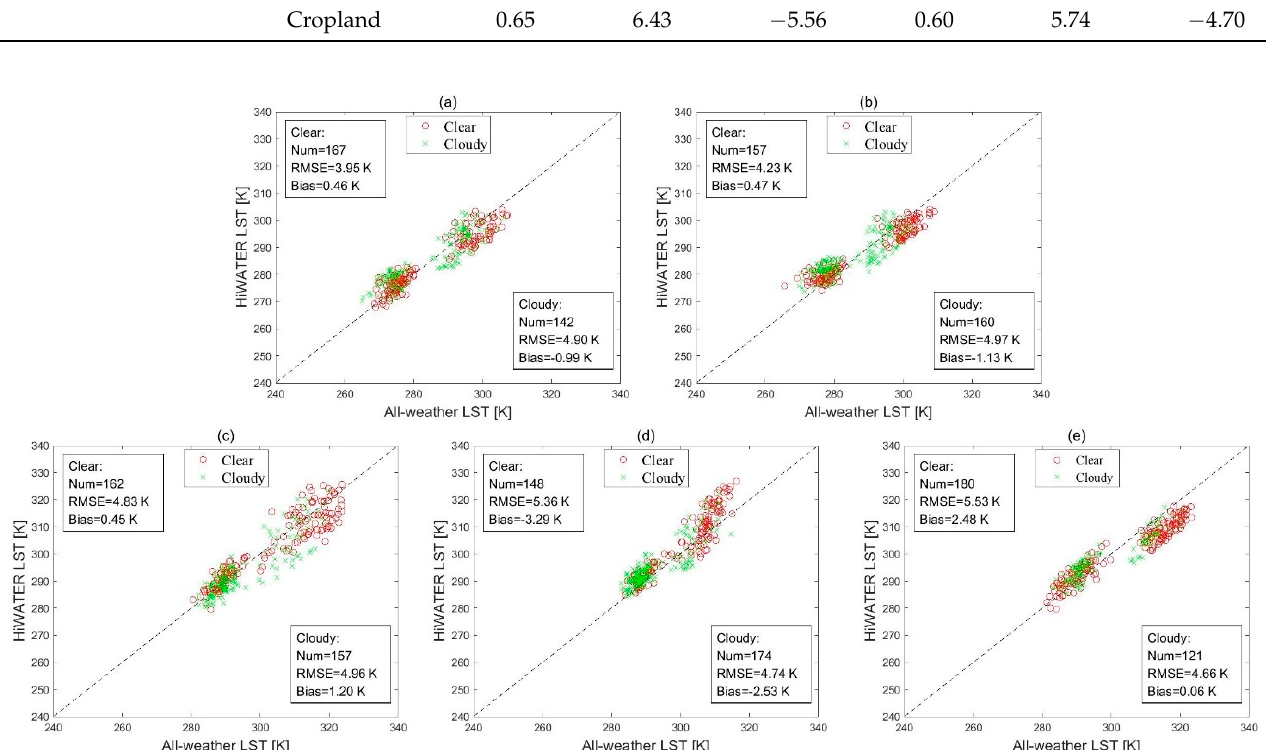
Figure 10. Scatterplots of the all-weather MODIS LST against the ground-measured LST at 5 HiWATER sites: ( a ) DSL; ( b ) AR; ( c ) HZZ; ( d ) HH, and ( e ) SDL in 2017.